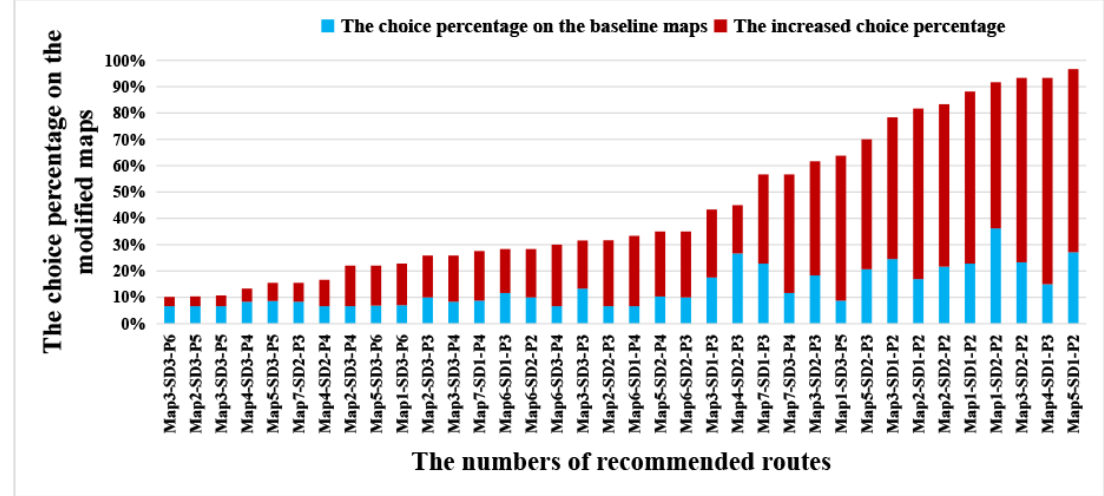
Figure 6. Route choice results for the modified maps.